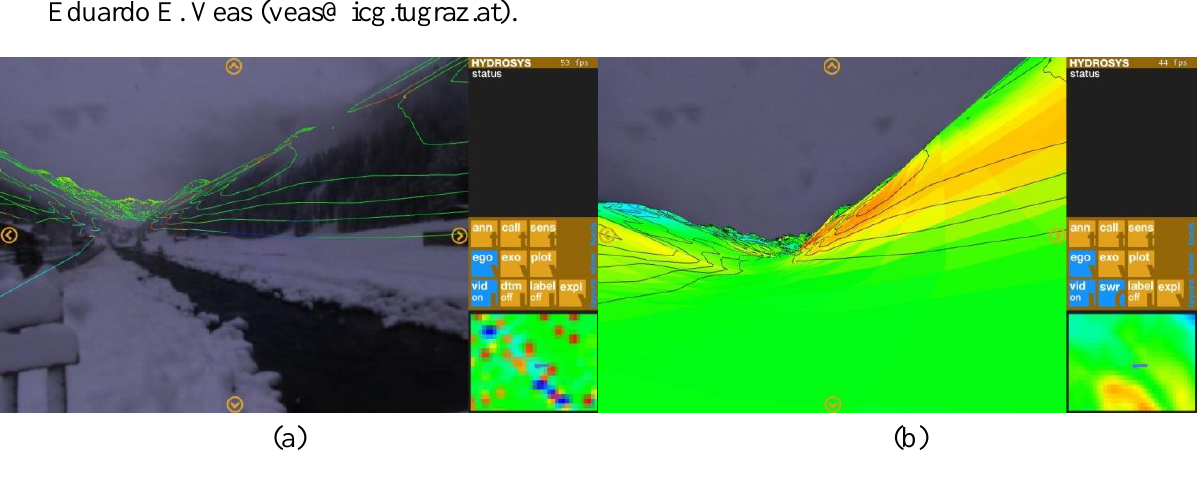
Figure 8. HYDROSIS augmented reality application prototype superposing environmental information on a camera picture as ( a ) iso-lines, and ( b ) colour-coded areas. Courtesy of Eduardo E. Veas